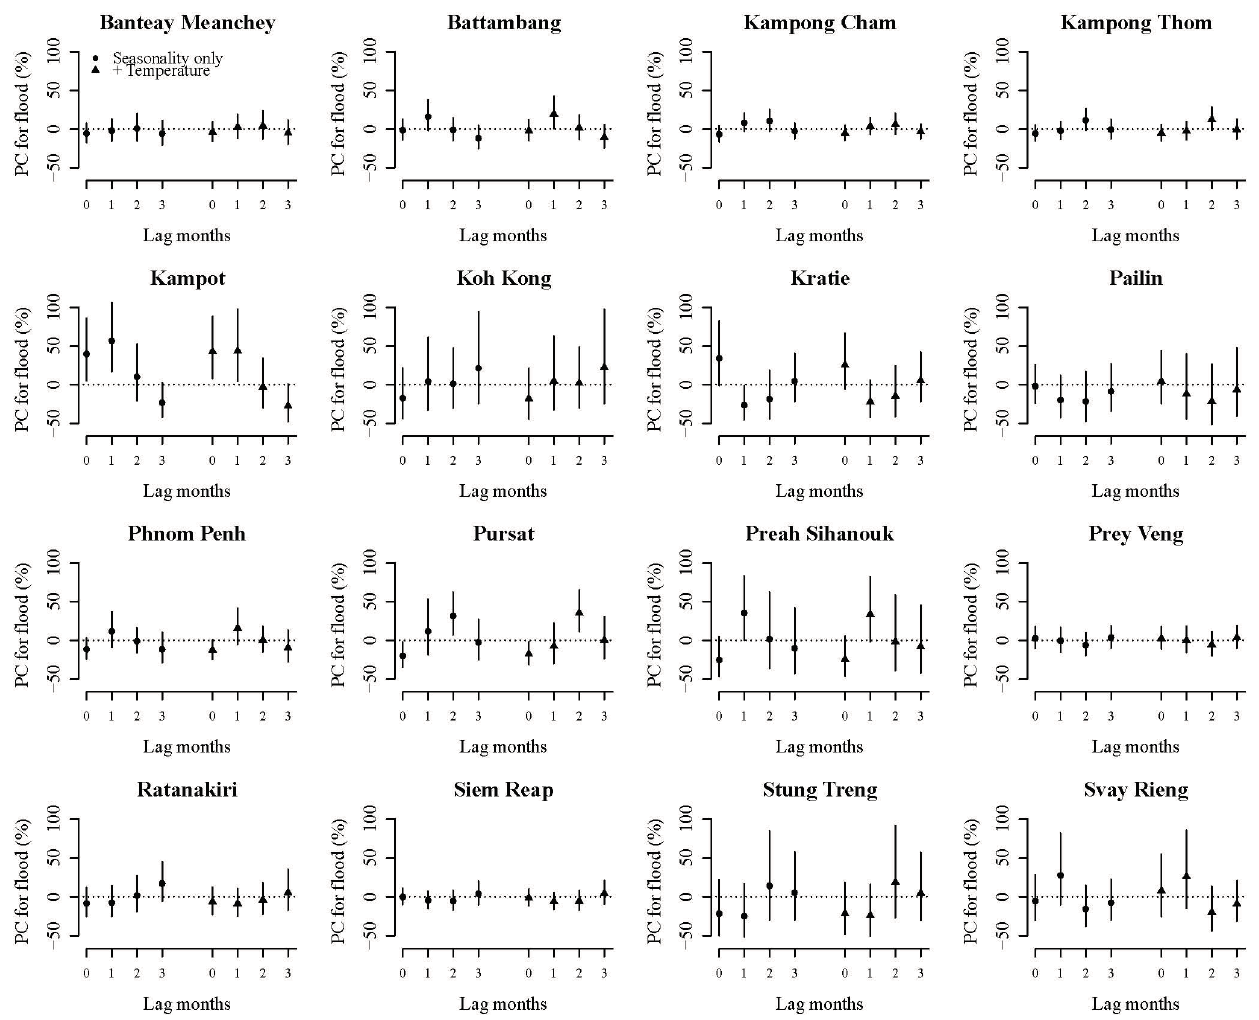
Figure 2. Flood effect on diarrhoeal disease cases in 16 Cambodian provinces. ‘PC’ indicates a percent change of the flood effect on diarrhoea in each province, meaning the change in diarrhoeal disease cases corresponding to flood events after adjusting for temperature, long-term time trend and seasonality. ‘Seasonality only’ indicates the simplest model adjusting for seasonality, long-term trends, and year. ‘+ Temperature’ indicates the model adding adjustment for mean temperature to the simplest model. In Kampot, the significant effect of flood on diarrhea was observed at lag0 and lag1; and the effect of flood decreased on the increase in lag months. In Pursat, the significant effects of flood on diarrhea was observed at lag2, meaning that flood events two months ago influenced the increase in diarrhoea cases observed, whereas a protective effect of flood on diarrhoea cases was observed at